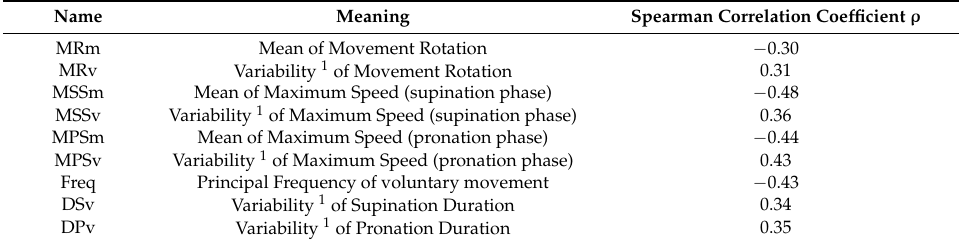
Table 5. List of significant parameters for Pronation Supination